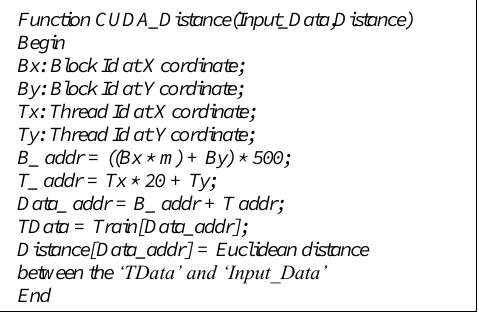
Algorithm 2.The pseudo code of calculating hamming distance between an input matrix and trained data using